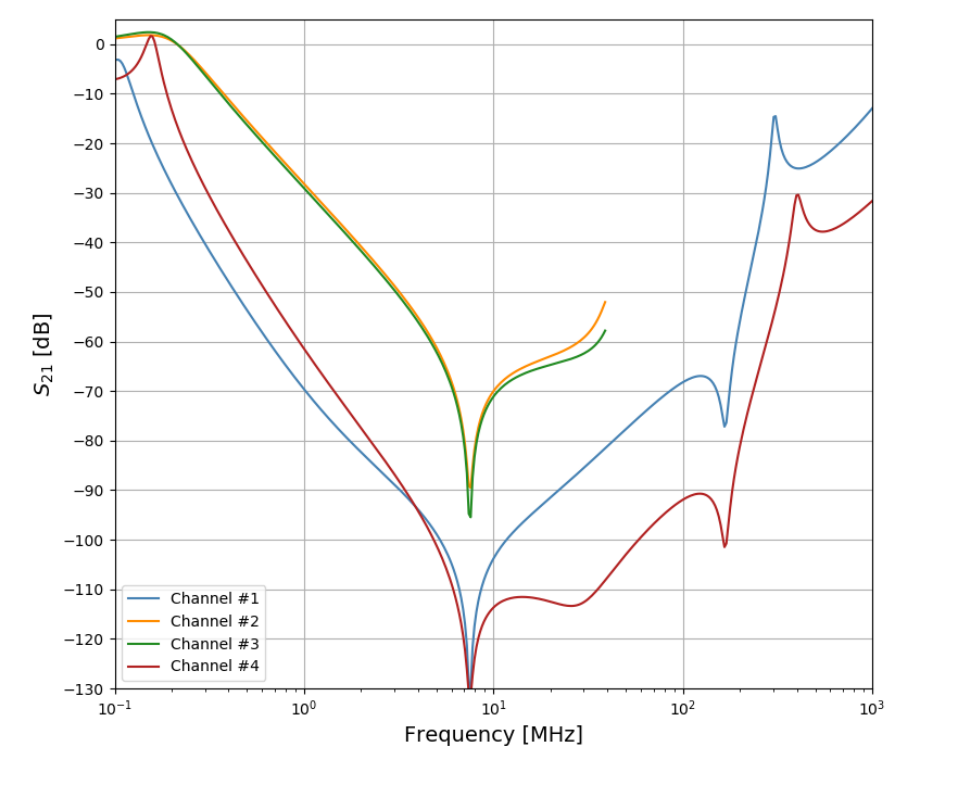
Figure 9. IL simulations of Test Board with realistic mean impedances (1 Ω + 30 nH at Voltage shifter output; 300 Ω //30 pF at CCD sensor